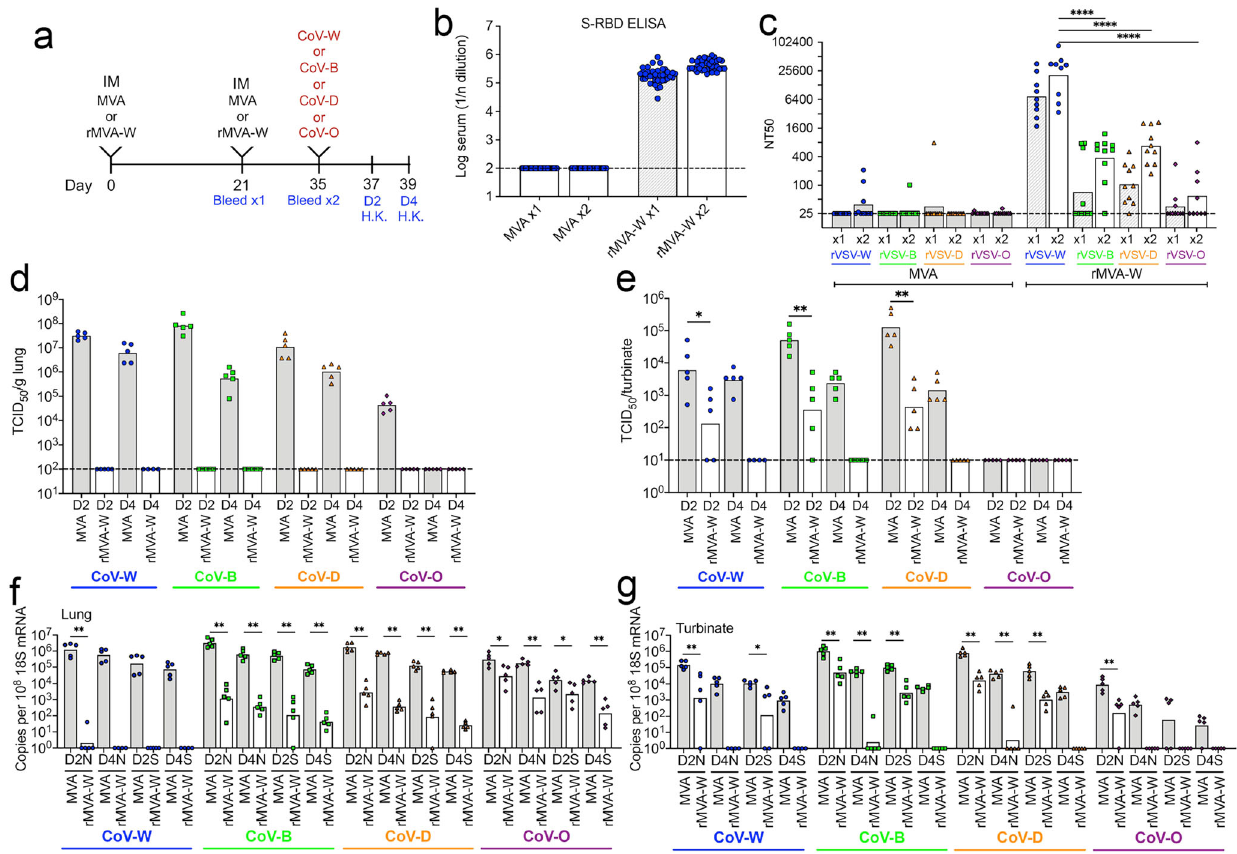
Fig. 3 Inhibition of early stages of variant SARS-CoV-2 infections in mice immunized IM with rMVA-W. a Timeline of K18-hACE2 mice vaccinated IM twice with 2 × 10 7 PFU of MVA control ( n = 40) or rMVA-W ( n = 40), divided into groups of 10 and challenged 2 weeks later with 10 4 TCID 50 of CoV-W, -B, -D or 5 × 10 4 TCID 50 of CoV-O. Half the mice were H.K. on day 2 and remainder on day 4. b Binding of serum antibodies to Wuhan RBD after fi rst and second immunizations determined by ELISA ( n = 40 per group). c Neutralization of pseudoviruses rVSV-W, -B, -D and -O by sera obtained after the fi rst and second immunizations ( n = 9 per group). Recovery of SARS-CoV-2 from d lungs and e nasal turbinates on days 2 ( n = 5 per group) and 4 ( n = 5 per group) after challenge. Copies of sgRNAs N and S relative to 18 S RNA from f lungs and g nasal turbinates on days 2 and 4 after challenge. ( n = same as in d and e ). Statistics: for c ANOVA with Tukey post-hoc; for e – g Mann-Whitney. * p ≤ 0.03; ** p ≤ 0.002; **** p < 0.0001. Dotted line, limit of